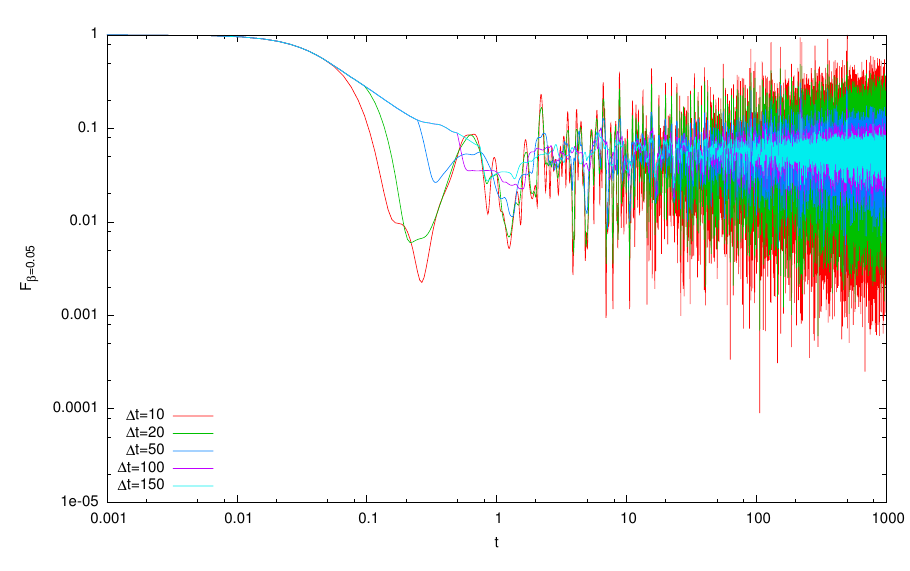
Figure 5 . SFF for (cid:12) = 0 : 05 for various window sizes ((cid:1) t ).